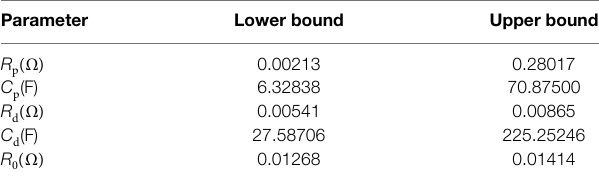
TABLE 2 | Parameter range of the SECM. Parameter